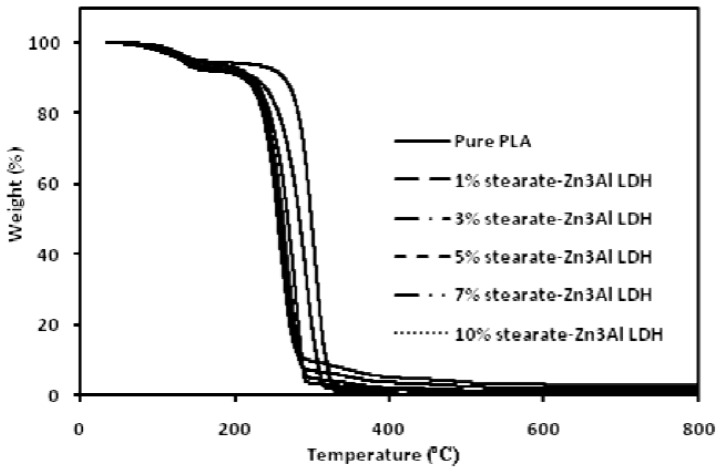
Thermogravimetric analysis (TGA) thermograms of the pure PLA and its stearate-Zn3Al LDH nanocomposites.